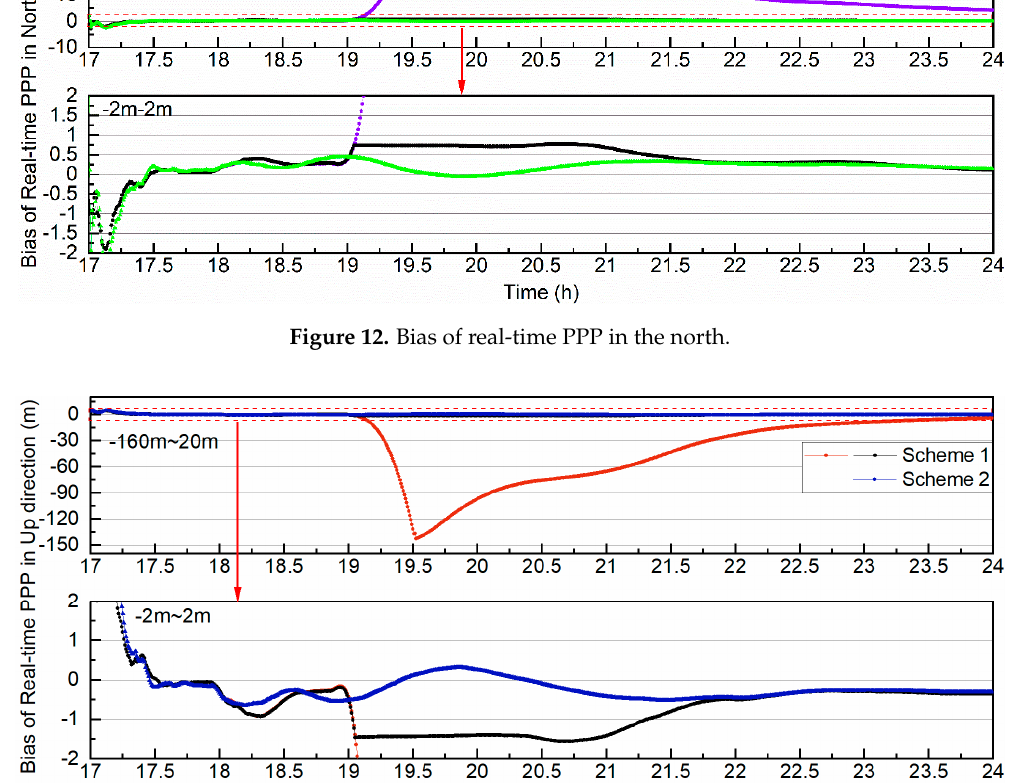
Figure 13. Bias of real-time PPP in the up